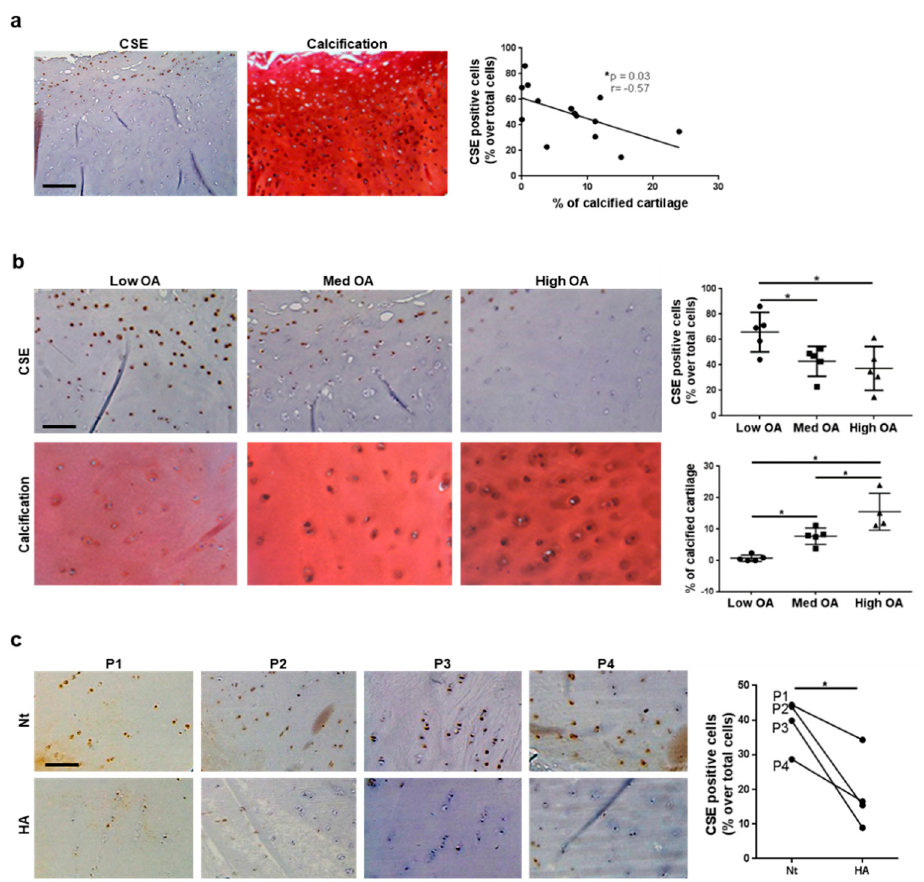
Figure 3. CSE expression negatively correlates with cartilage calcification in humans. ( a ) CSE immunohistochemical staining in cartilage from individuals with osteoarthritis (OA) and consecutive sections stained with von Kossa/Safranin − O staining for crystals. For each staining, one representative picture from one of 14 patients is shown. Scale bars 200 μ m. The graph shows the correlation between the % of CSE positive cells and the % of calcified cartilage in the different patients. n = 14 patients. ( b ) CSE immunohistochemical staining in cartilage from individuals with low, medium and high stage osteoarthritis and consecutive sections stained with von Kossa/Safranin-O staining for crystals. For each staining, one representative picture from one of 5 patients per group is shown. Scale bars 200 μ m. Graphs show quantification of the % of CSE positive cells and the % of calcified cartilage. For each patient, three fields were counted per explant and the mean plotted in the graph. n = 15 patients. ( c ) CSE immunohistochemical staining in human cartilage explants untreated (Nt) or stimulated with 500 μ g/mL HA crystals for 24 h. Scale bars 200 μ m. The graph shows the % of CSE positive cells in Nt and HA − stimulated explants in the different patients. For each patient, three fields were counted per explant and the mean plotted in the graph. Lines connect the Nt condition to the HA condition for each patient. n = 4 patients (P1 − P4). Statistics: * p < 0.05